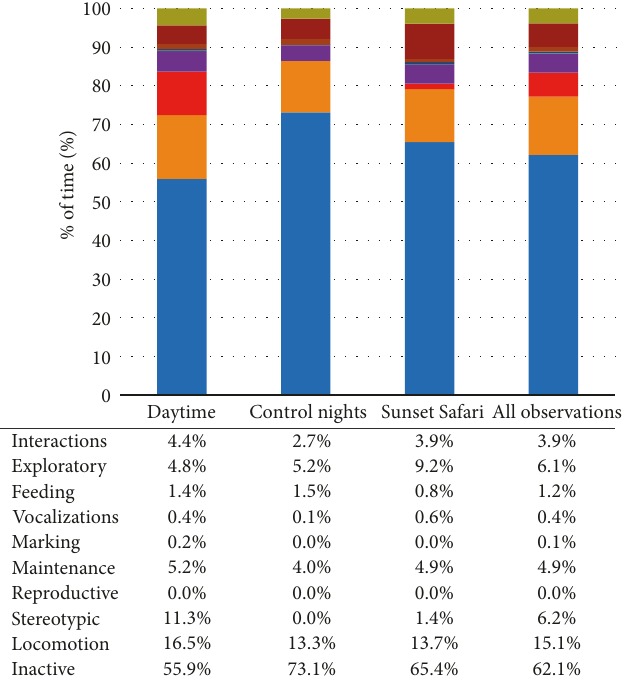
Figure 3: Indi’s time budget for each observation period and overall at London Zoo. Data values are included to show exact percentages of time for each behavior class.